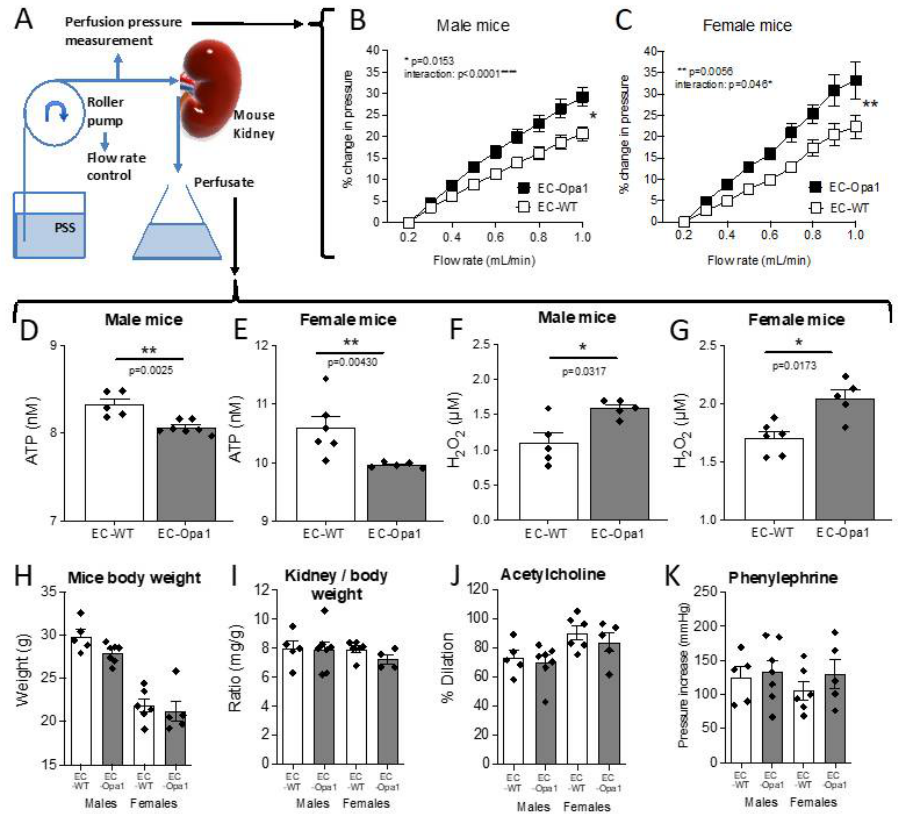
Figure 6. Consequences of Opa1 deficiency in endothelial cells on the kidney perfusion pressure and on kidney ATP and H 2 O 2 production. In isolated and perfused kidneys ( A ), the flow-pressure relationship was determined in mice lacking Opa1 in endothelial cells (EC-Opa1 male, B , and female mice, C ) and in littermate wild-type mice (EC-WT). The level of ATP ( D , E ) and H 2 O 2 ( F , G ) was quantified in the perfusate collected from the perfused kidneys under a flow rate of 600 µ L/min. H : mice body weight, I : ratio kidney/body weight, J : Acetylcholine (1 µ M)-mediated dilation, and K : Phenylephrine (1 µ M)-mediated contraction. Means ± the SEM are shown (n = 6 EC-WT and 7 EC-Opa1 male mice and n = 6 EC-WT and 5 EC-Opa1 female mice).* p >0.05, ** p < 0.01,